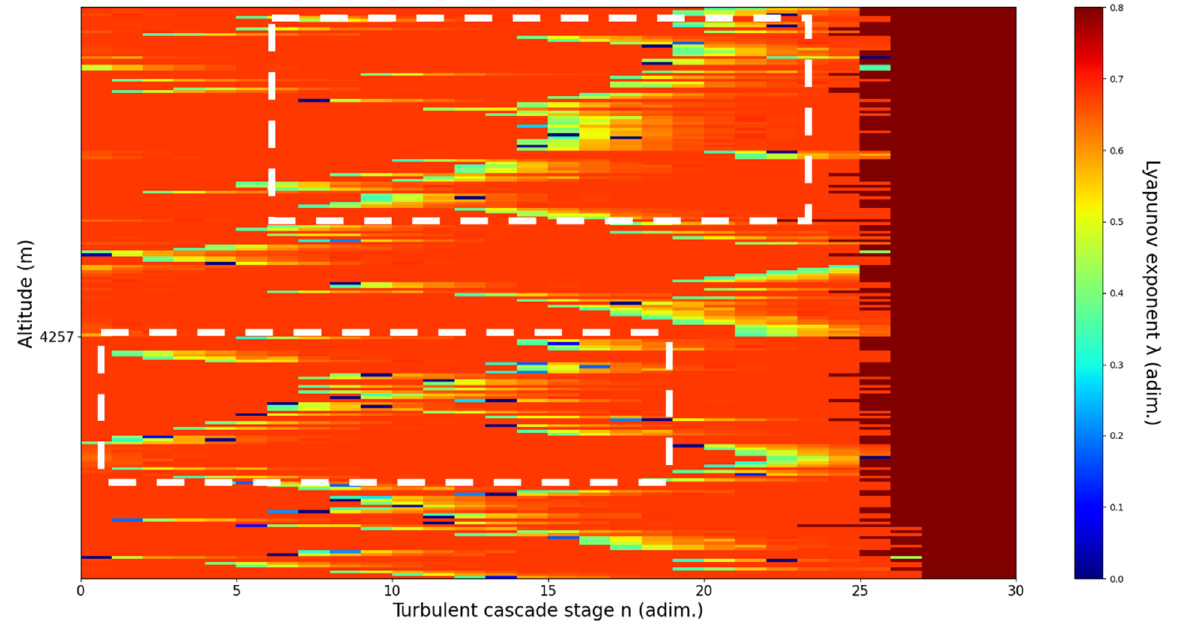
Figure 20. Lyapunov exponent per turbulent cascade stage colormap altitude plot, Bucharest, Romania, 13 June 2019,